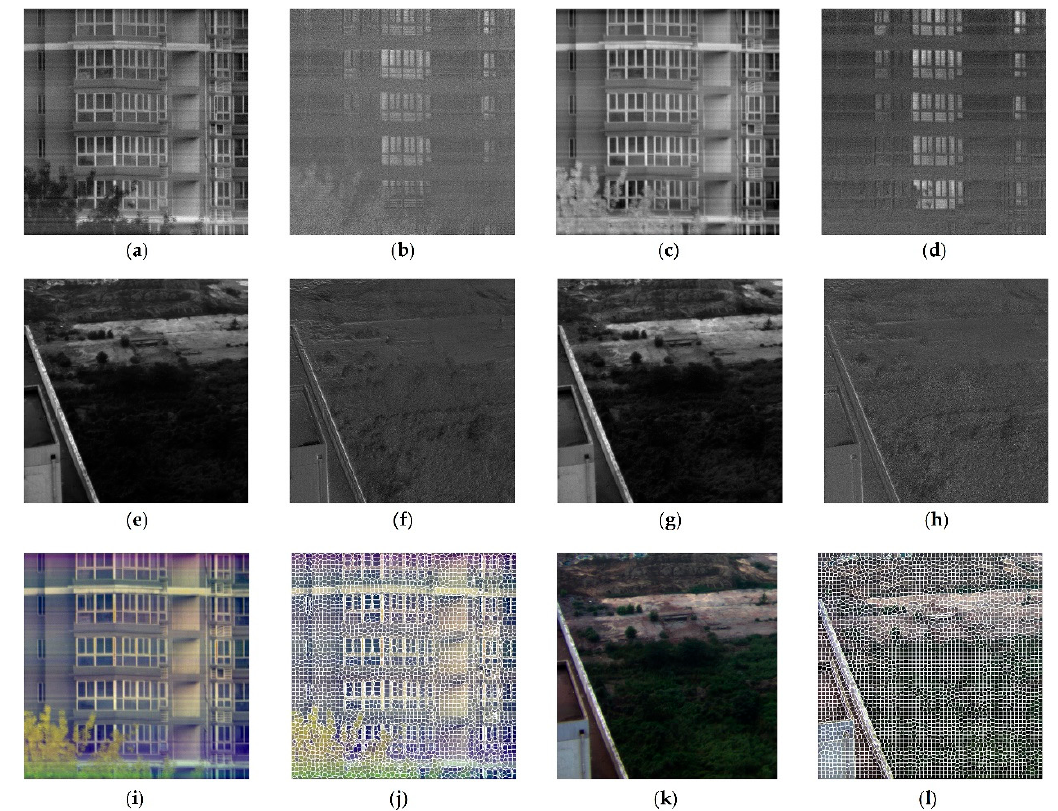
Figure 3. Images of dataset A and dataset B: ( a ) S 0 image of dataset A at 690 nm; ( b ) degree of linear polarization (DOLP ) image of dataset A at 690 nm; ( c ) S 0 image of dataset A at 778 nm; ( d ) DOLP image of dataset A at 778 nm; ( e ) S 0 image of dataset B at 480 nm; ( f ) DOLP image of dataset B at 480 nm; ( g ) S 0 image of dataset B at 690 nm; ( h ) DOLP image of dataset B at 690 nm; ( i ) false color image of dataset A; ( j ) 3249 superpixels of dataset A; ( k ) false color image of dataset B; ( l ) 3249 superpixels of dataset B .